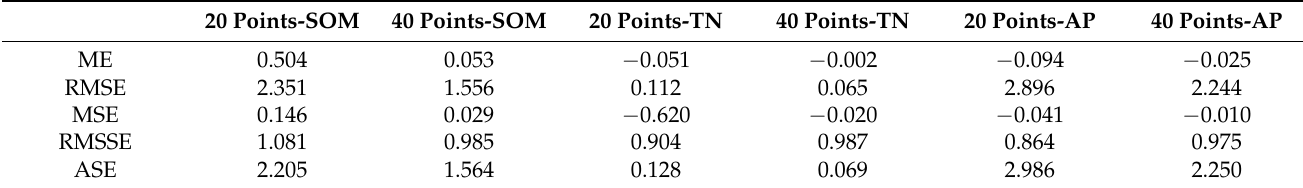
Table 4. The validation of the Kriging interpolation using 20 and 40